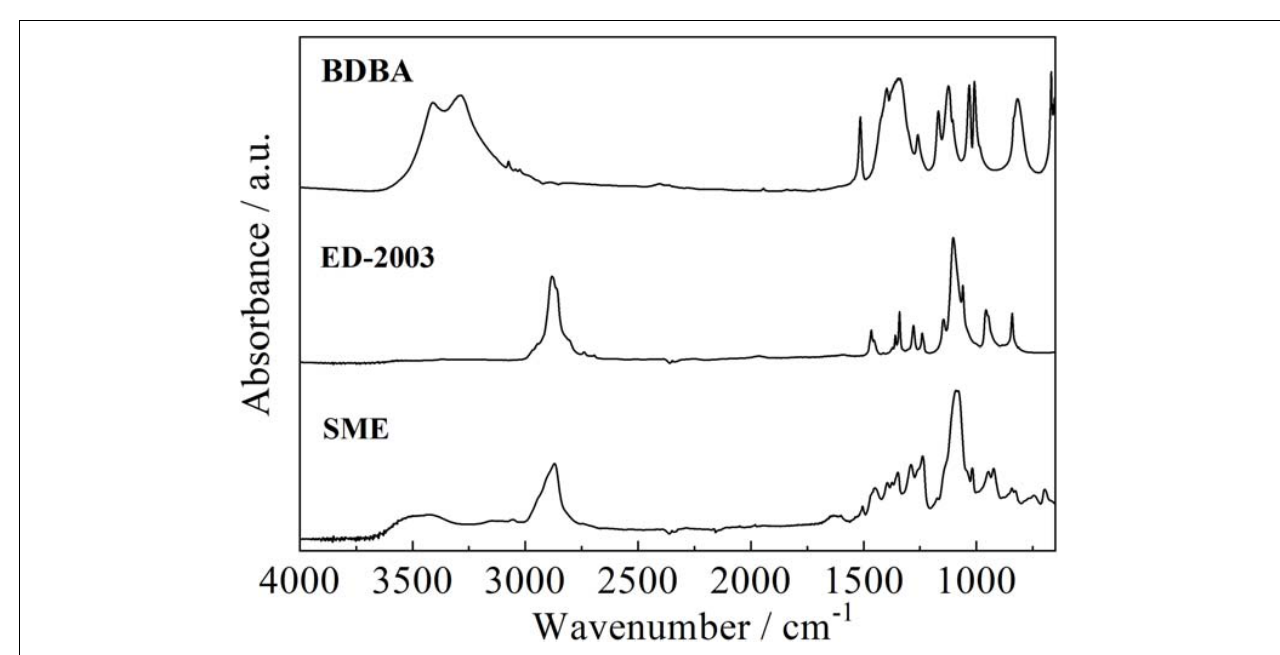
FIGURE 3 | FT-IR spectra of BDBA, ED-2003, and